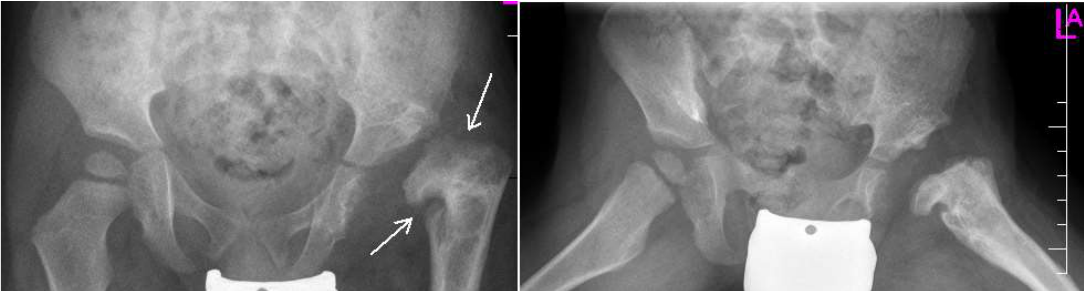
Figure 2. Radiographs: Antero-posterior (AP) and Lauensteun view of three weeks old child’s left hip, slightly out of the socket (eccentric hip).